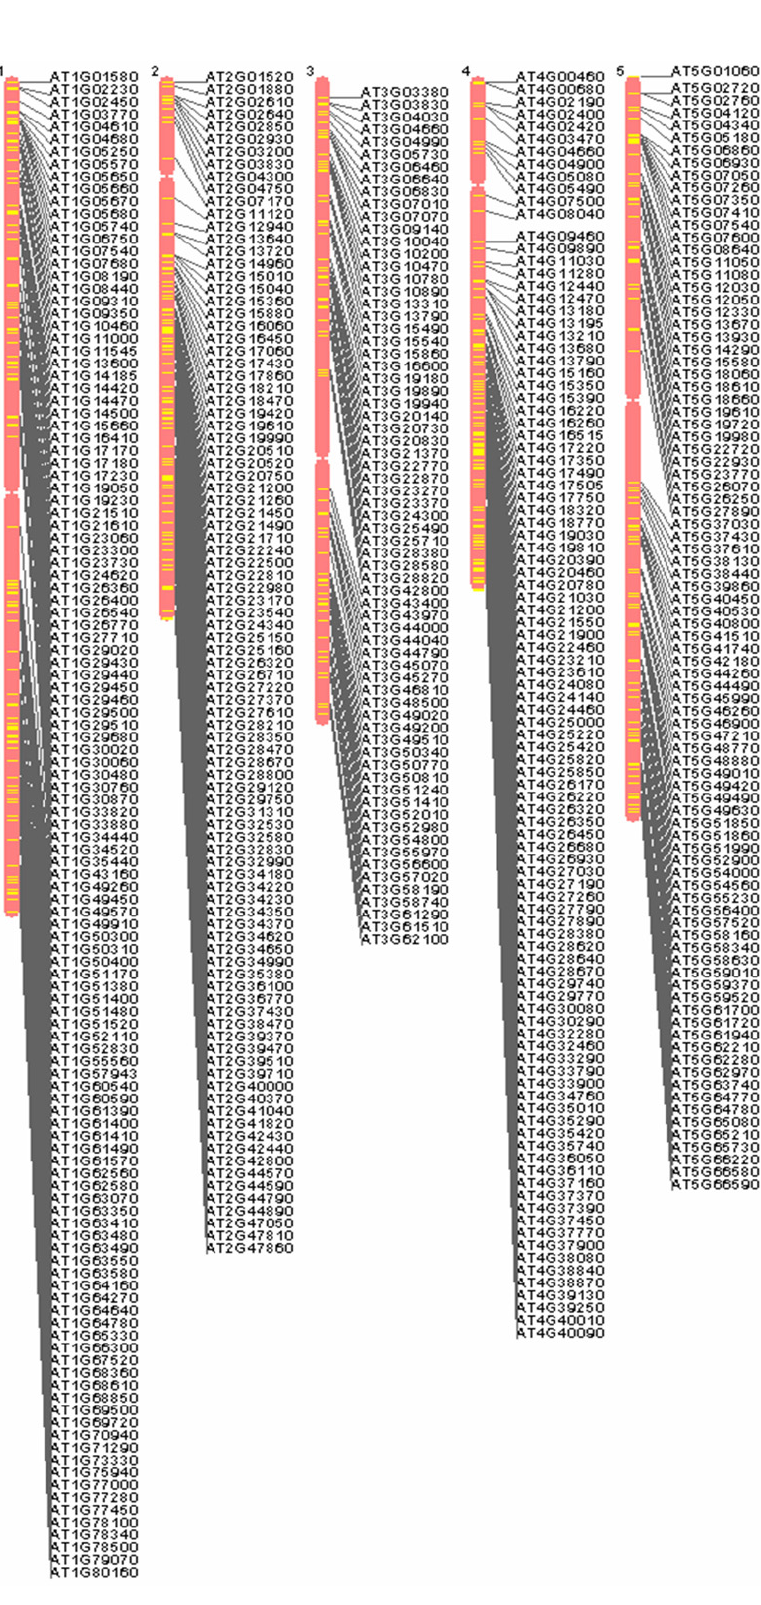
Figure 1. Locations of auxin-responsive genes along the chromosomes based on a list of locus names.